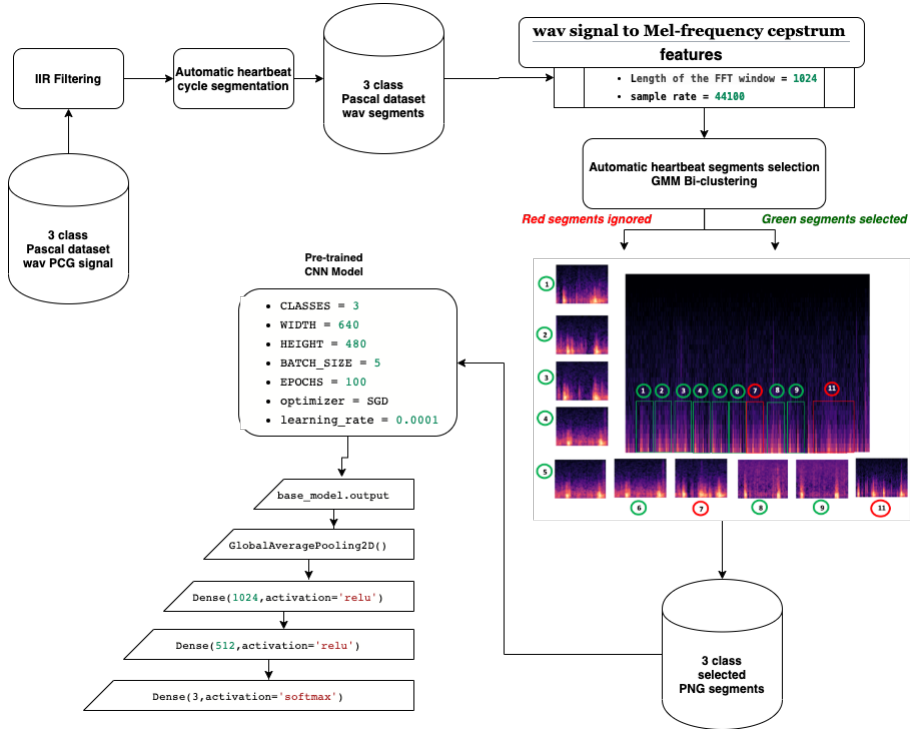
Figure 1. Proposed heart sound detection